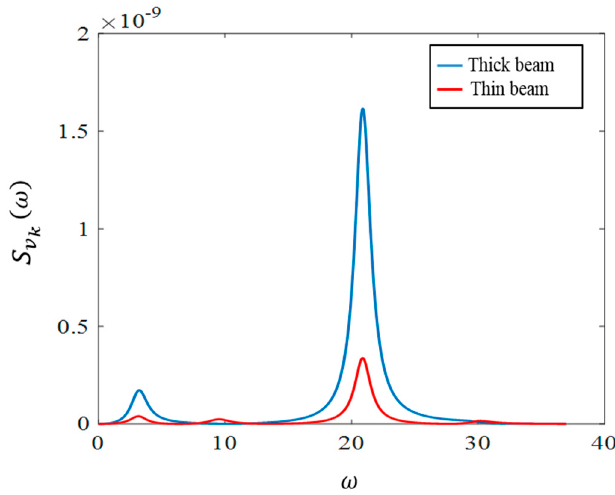
Figure 9. Spectral density of the generated voltages.